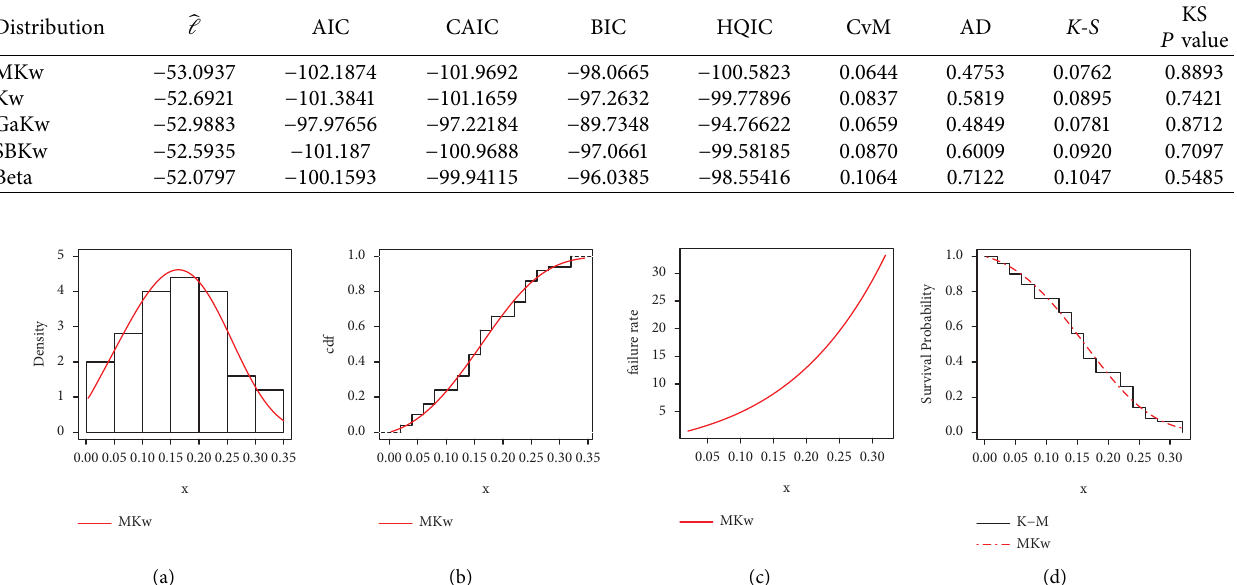
Table 16: Te statistics AIC, CAIC, BIC, HQIC, CvM, AD, and K - S for data set 5.